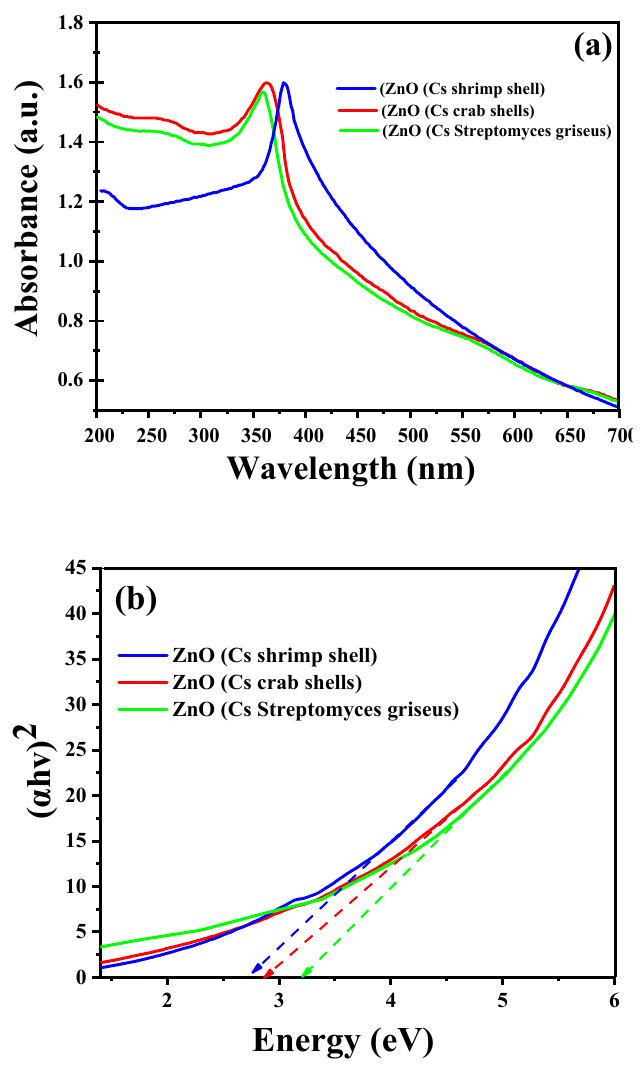
Figure 4. The optical properties of ZnO NPs from chitosan of shrimp shells, crab shells, and Streptomyces griseus bacteria . ( a ) UV-Visible spectrum, and ( b ) optical energy bandgap.